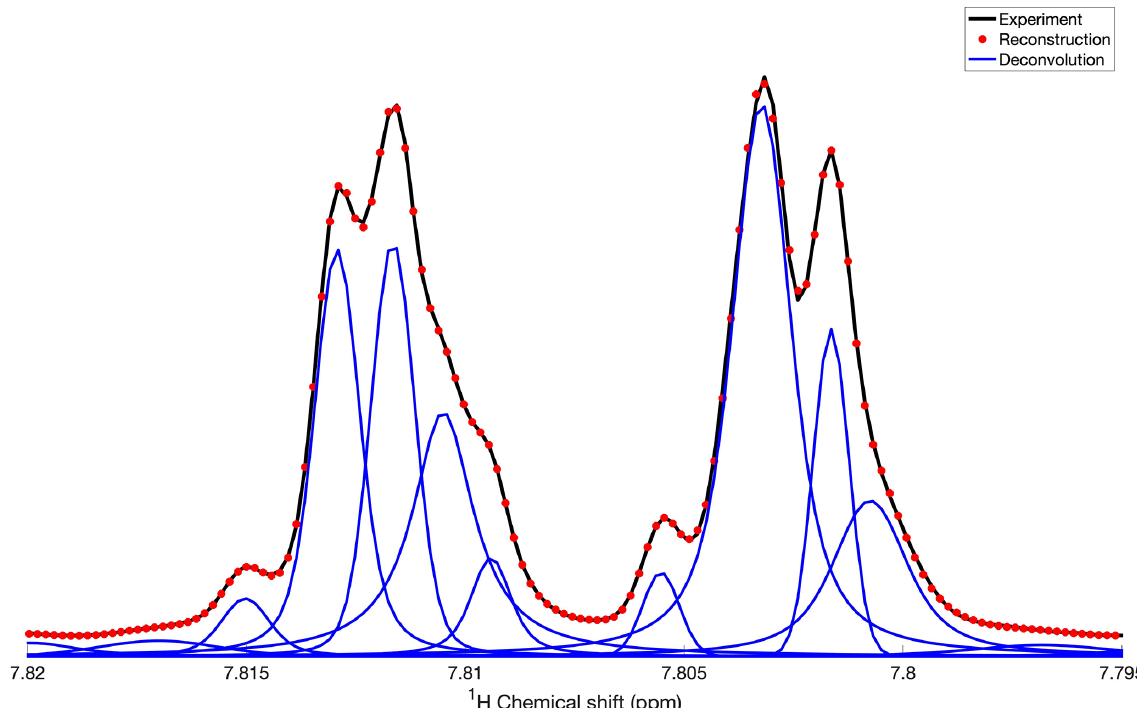
Figure 3. Application of DEEP Picker1D and Voigt Fitter1D to a spectral region of the 1D 1 H spectrum of mouse urine. Experimental and reconstructed spectra are depicted as black lines and red dots, respectively. Deconvoluted individual peaks are depicted as blue lines. The deconvolution by DEEP Picker1D was performed with model 2 with a PPP number of